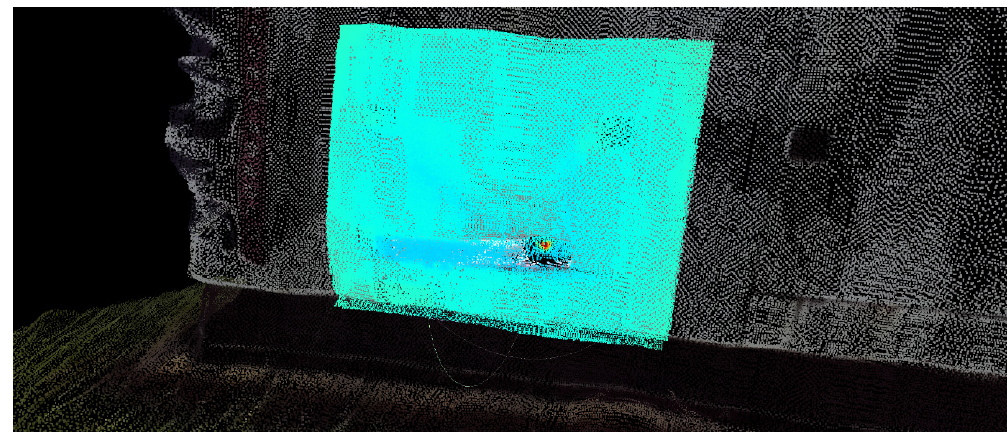
Figure 3. Instant thermal